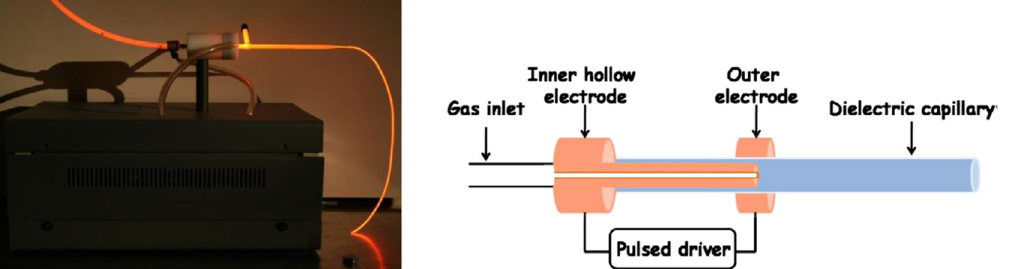
Figure 12. Plasma gun device filled with a neon discharge generated by DBD reactor. The discharge is ignited with a nanosecond pulse driver and leaves the DBD outlet through a 4 mm branched glass capillary, which is connected to a silicone capillary acting as an APPJ guide. Reprinted/adapted with permission from Ref. [48]. Copyright 2013, Elsevier GmbH.